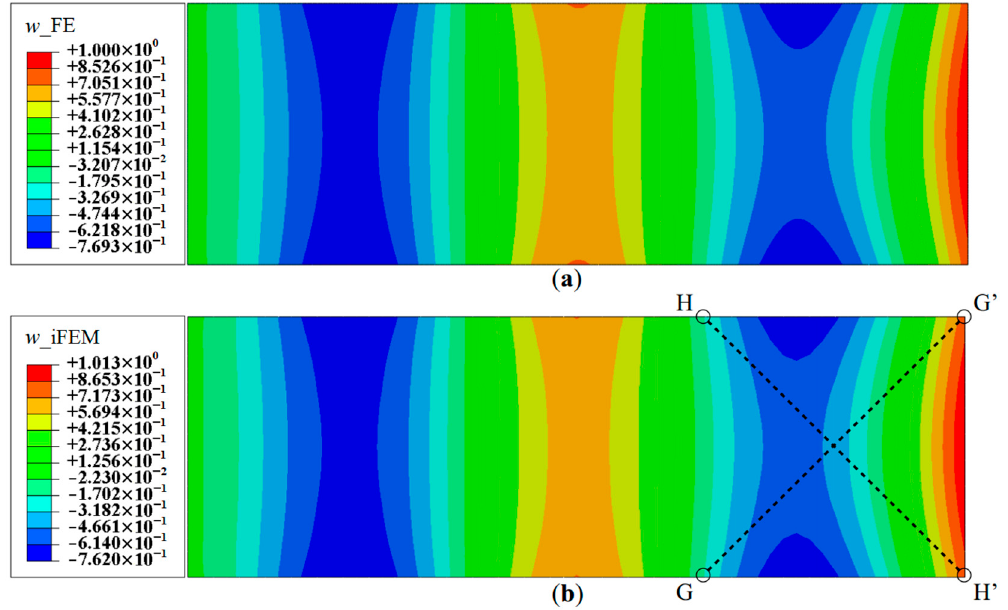
Figure 11. Contour plots of deflection for Mode 6: ( a ) FE results; and ( b ) iFEM results using full-field strain data (Configuration-D).